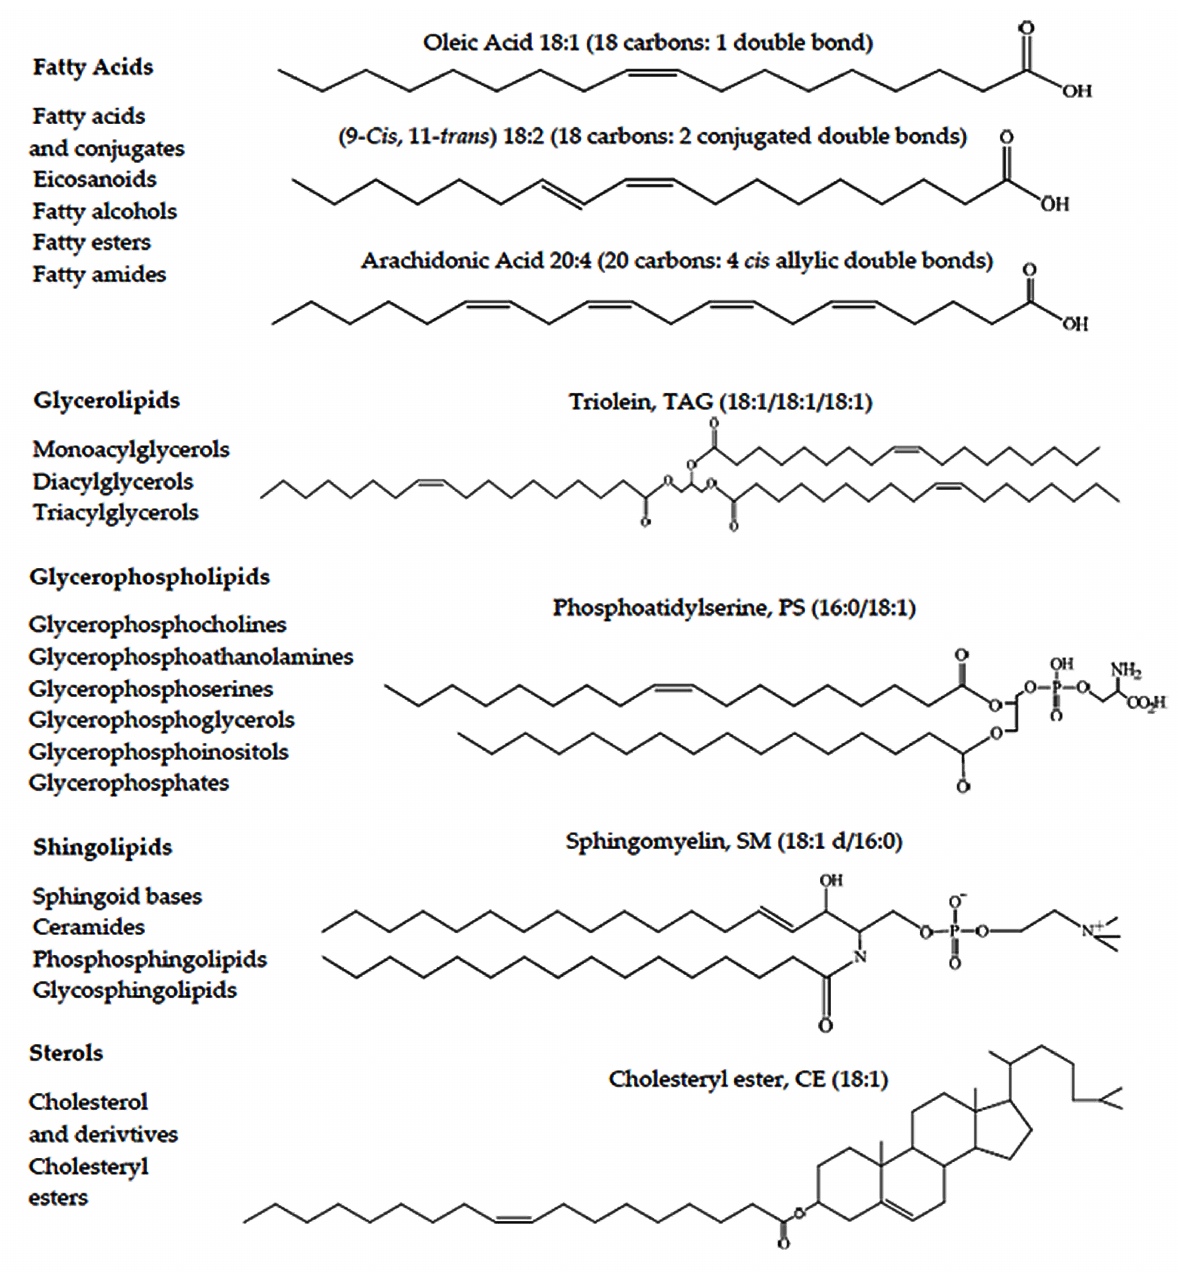
Figure 1. Representative structures of various classes of lipids. Adopted, with permission, from [14]. Copyright 2012, Wiley